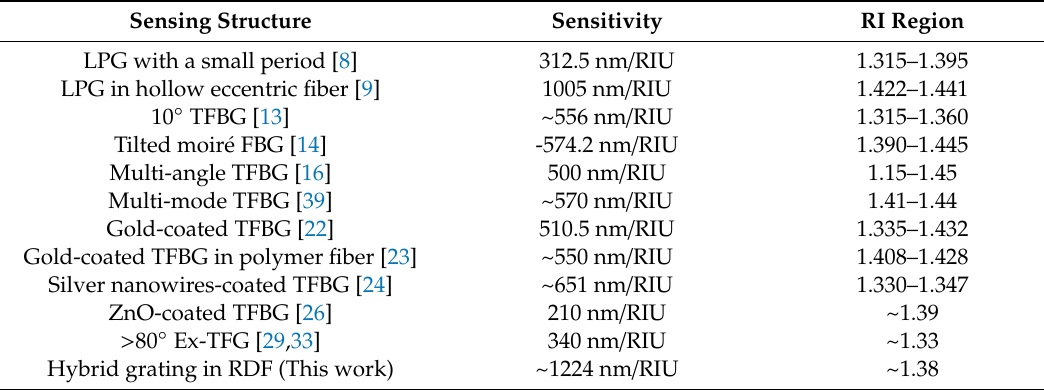
Table 1. Comparison of sensitivity between fiber grating-based RI